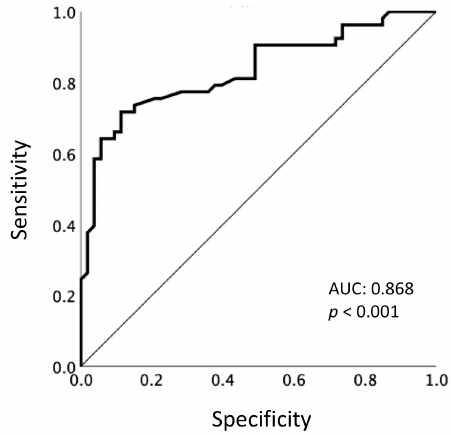
Figure 2. Receiver operating characteristic curve of the association between early tumor shrinkage and long-term response (PFS ≥ 5.0 months). PFS, progression-free survival; AUC, area under the curve.